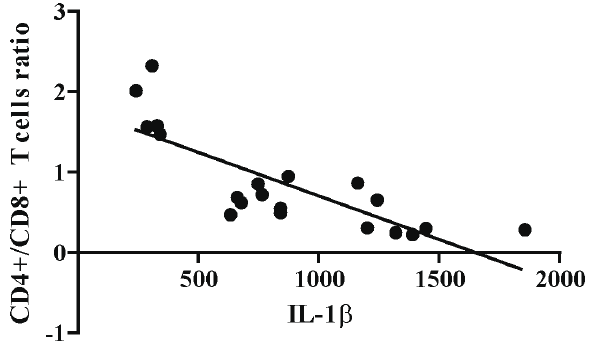
Fig. 4. The serum level of IL-1 β and CD4+/CD8+ T cells ratio was negatively correlated on the treatment of Kanglaite. The serum level of IL-1 β in Fig. 3 and the CD4+/CD8+ T cells ratio in Fig. 2 were analyzed using linear regression, and they were negatively correlated. R 2 = 0.6410 and P < suggested that Kanglaite specifically downregulated IL-1 β expression in tumor tissues without affecting cir- culating lymphocytes.